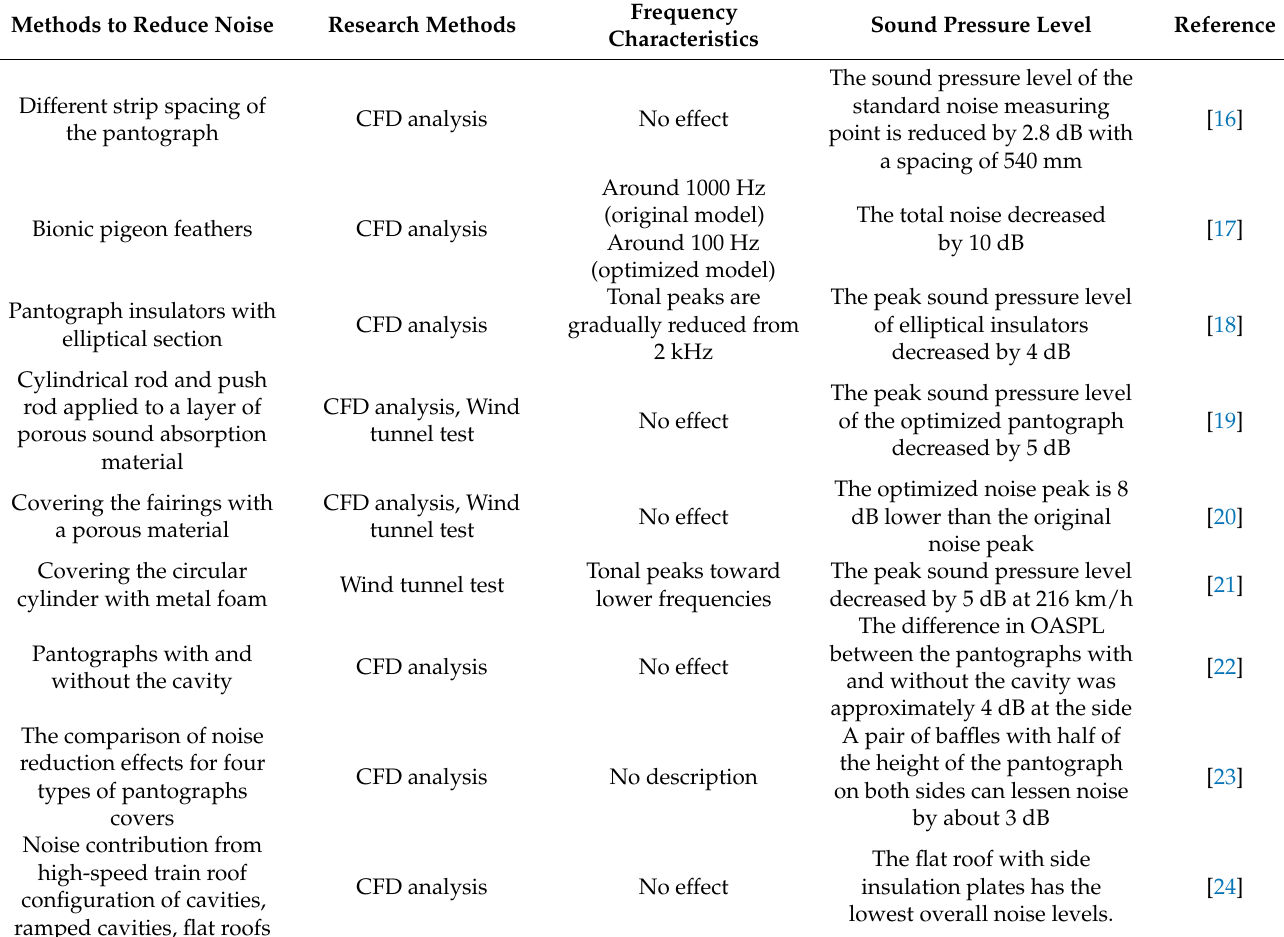
Table 1. Comparison of noise reduction measures for